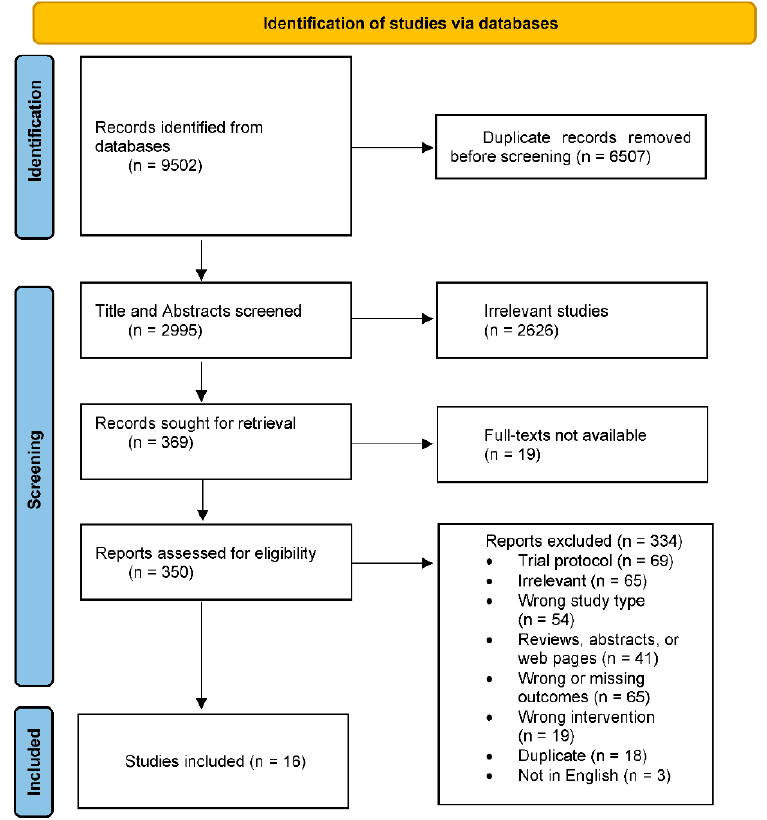
Figure 1. Flow diagram of search strategy and included studies and trial comparisons.